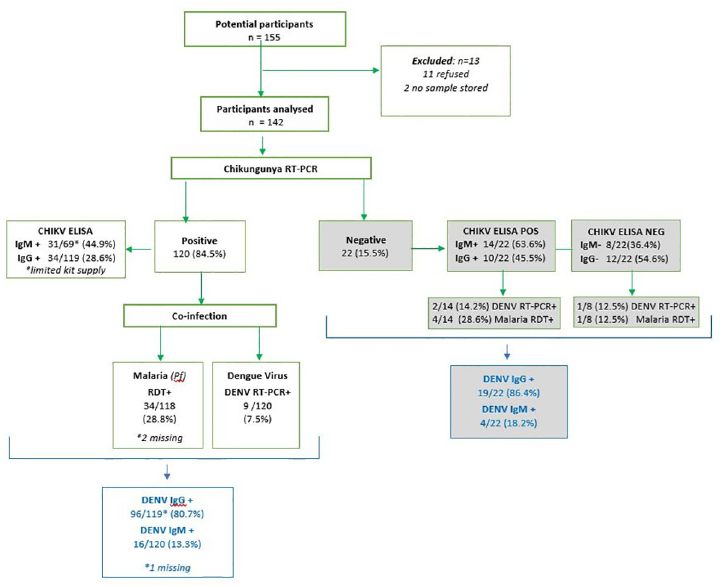
Fig 2. Flow diagram of study participants and virological findings: CHIKV : Chikungunya; DENV : Dengue Virus . ELISA IgM testing was limited by kit availability: CHIKV RT-PCR-negative samples were prioritised, followed 69 CHIKV RT-PCR positive samples in order of